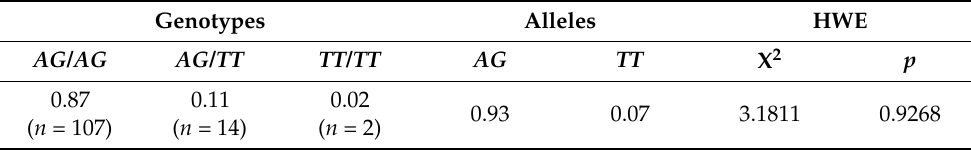
Table 1. Distribution of CRY1 genotypes and alleles in analyzed